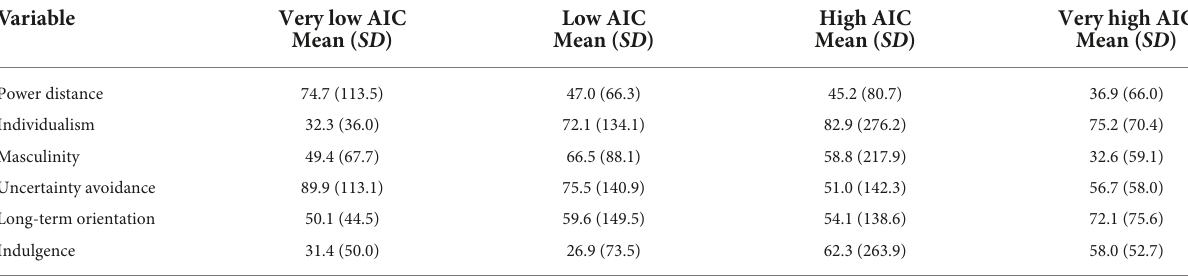
TABLE 5 Description of the AIC groups based on national cultural dimensions: weighted data analysis.